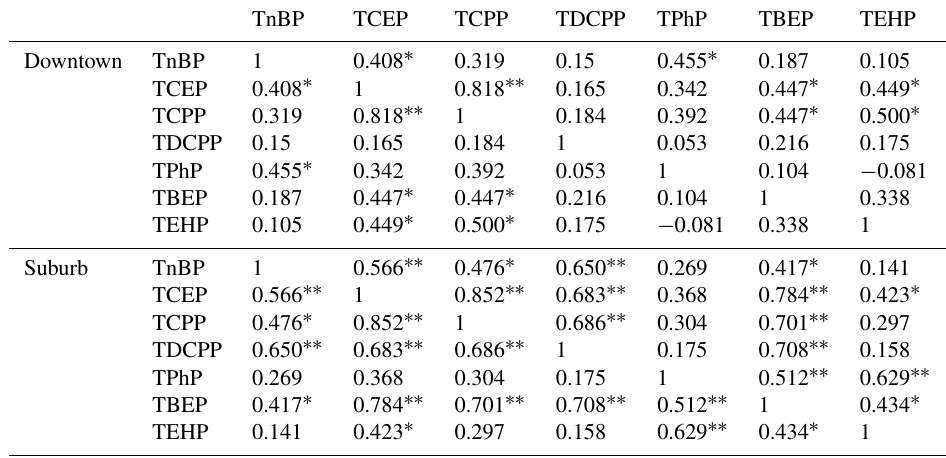
Table 2. The correlation analysis of individual OPEs in downtown and suburb sampling sites.